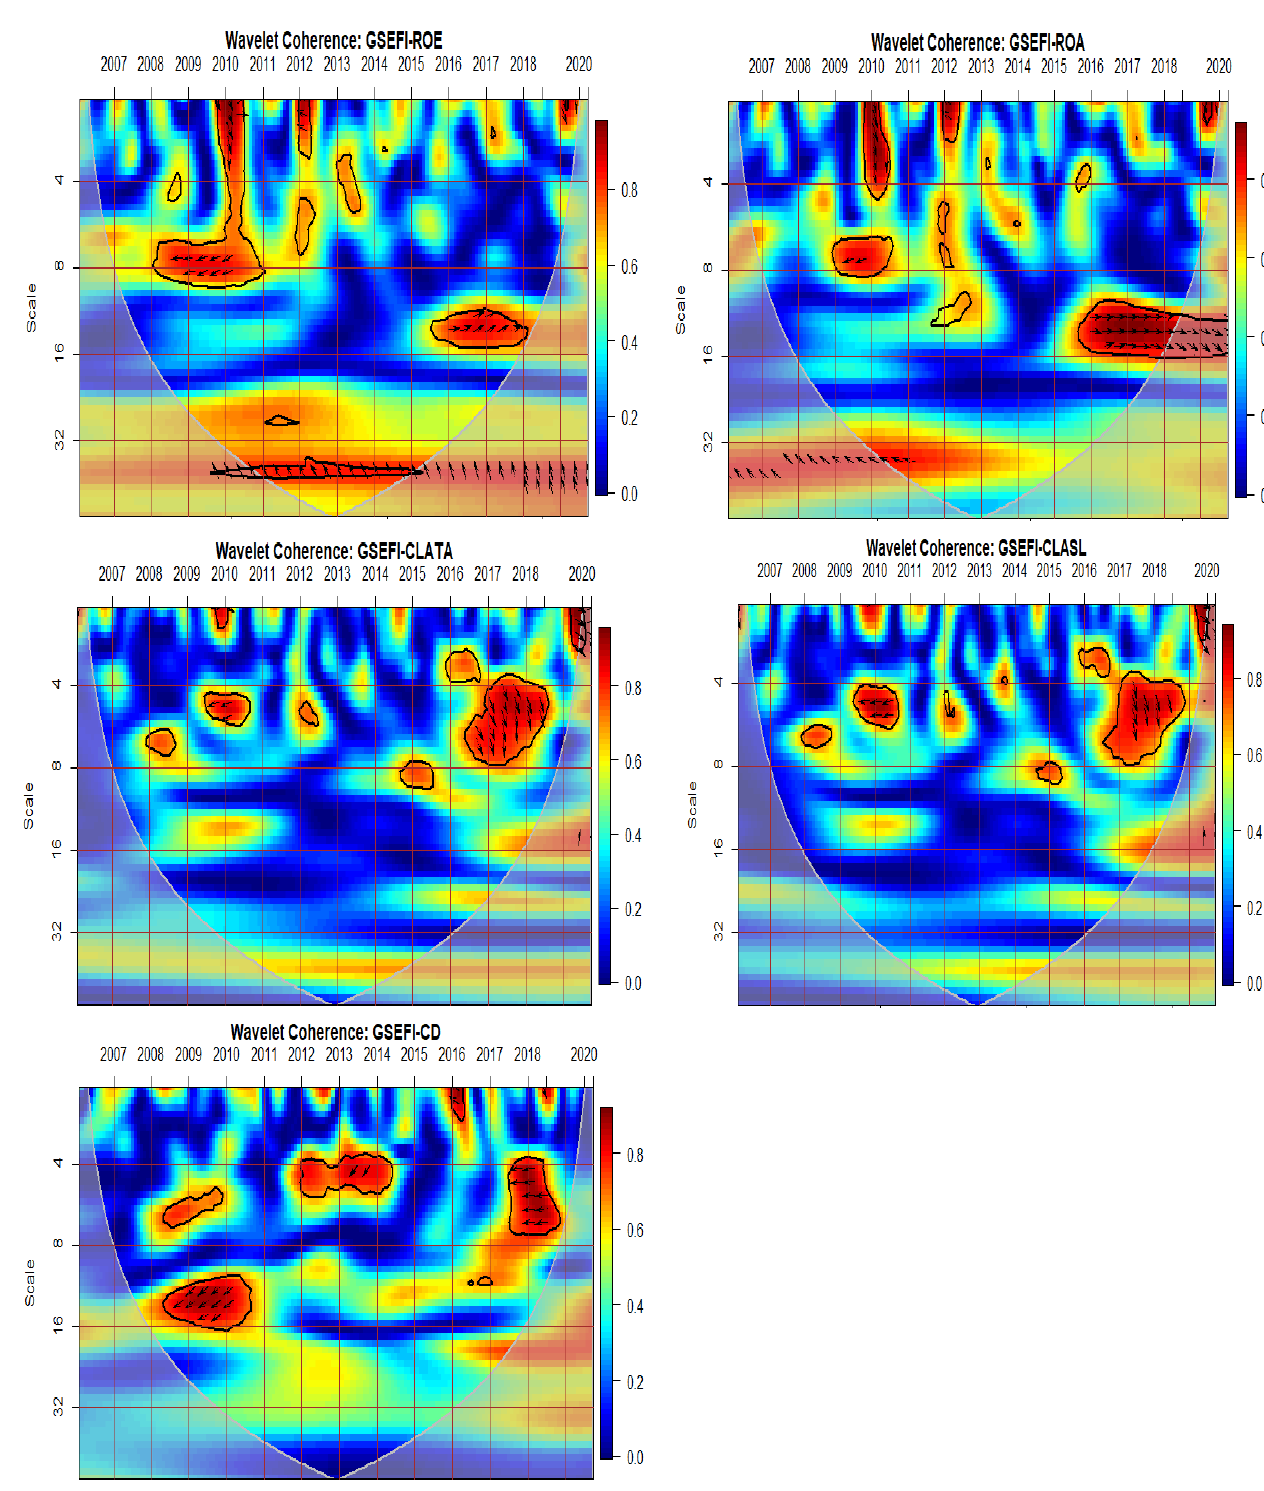
Figure 4. Comovements between GSEFI and banking sector financial soundness.